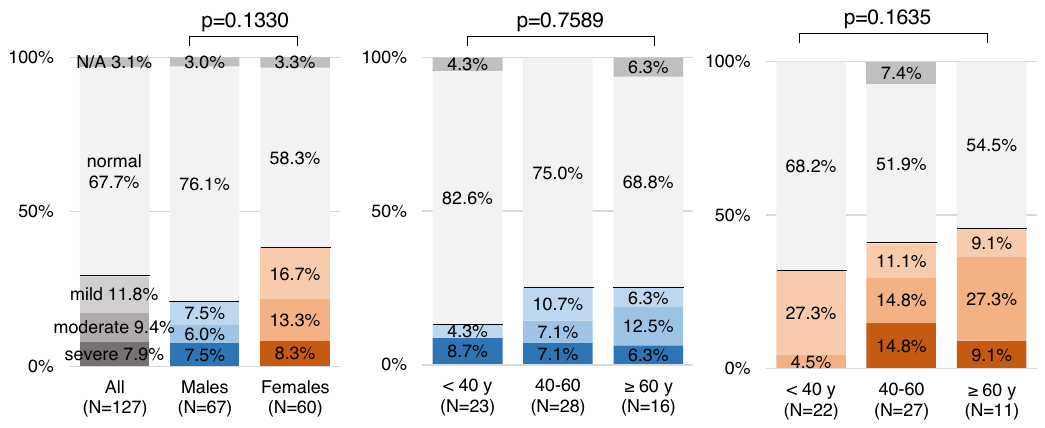
Figure 4. Prevalence rates of deficits in work performance assessed using the WFun questionnaire. The Work Functioning Impairment Scale (WFun) was developed to evaluate deficits in work performance. Total scores of 7–13 were classified as normal, and scores ≥ 14 suggested possible impairments in work performance (14–20, mild; 21–27, moderate; and 28–35, severe). The gray, blue, and orange colors show the distribution of WFun scores for all subjects, males, and females, respectively. The intensity of the color relates to the severity of impairments in work performance. Chi-square test was applied to compare the distributions of WFun scores by sex and age group.